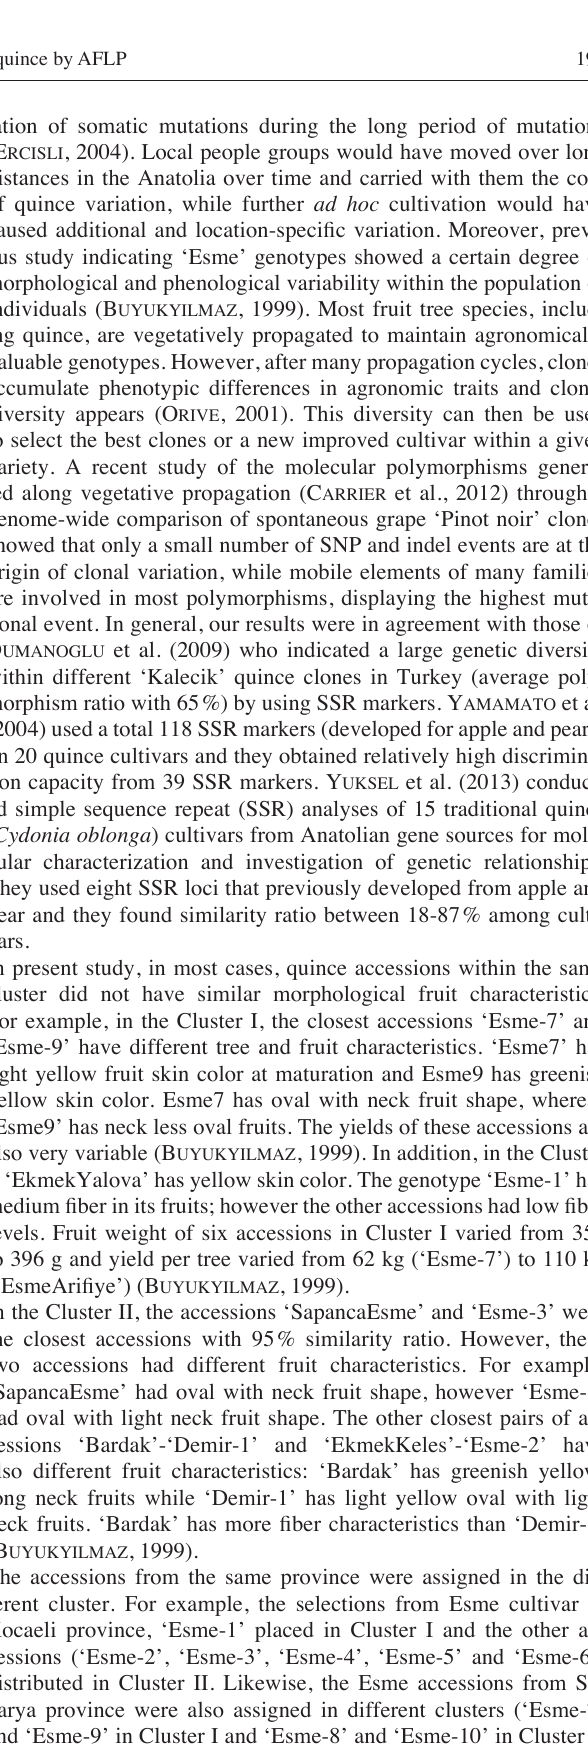
Fig. 1: Dendrogram of 40 quince genotypes originating from Turkey result- ing from the unweighted pair-group method of arithmetic mean clus- ter analysis based on Jaccard similarity coefficient obtained from 746 AFLP